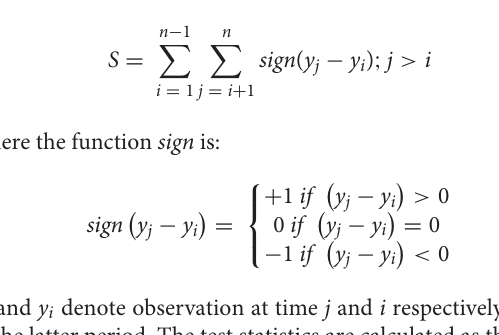
TABLE 1 | Extreme Precipitation Indices introduced by ETCCDI